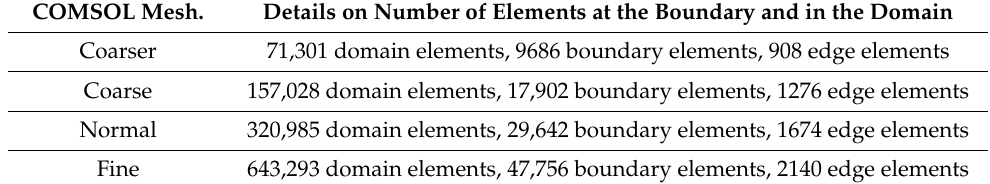
Table 2. Mesh information for different level of meshing [33]. COMSOL